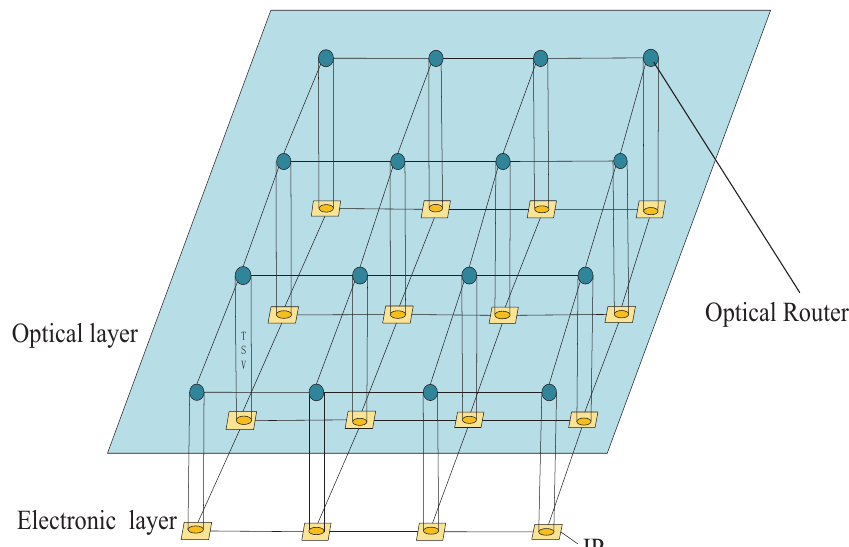
Figure 1. Hybrid optical mesh network-on-chip (NoC)